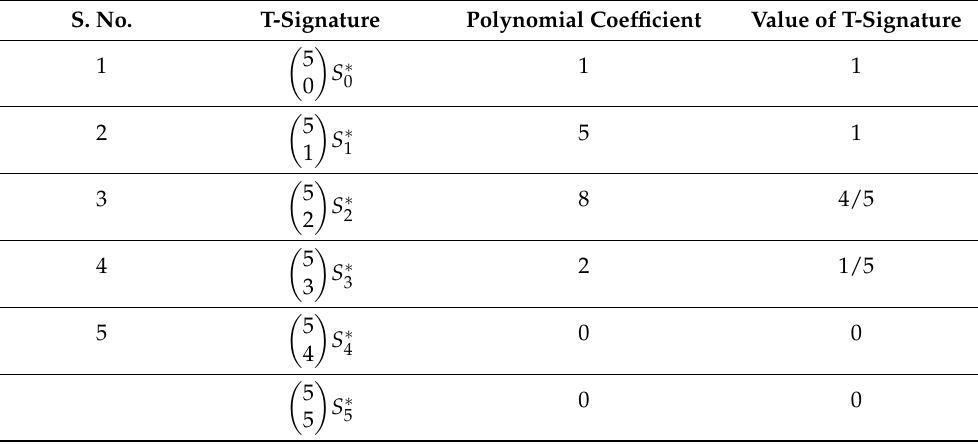
Table 2. The values of tail signature of the bridge system by using binomial formula. S. No. T-Signature Polynomial